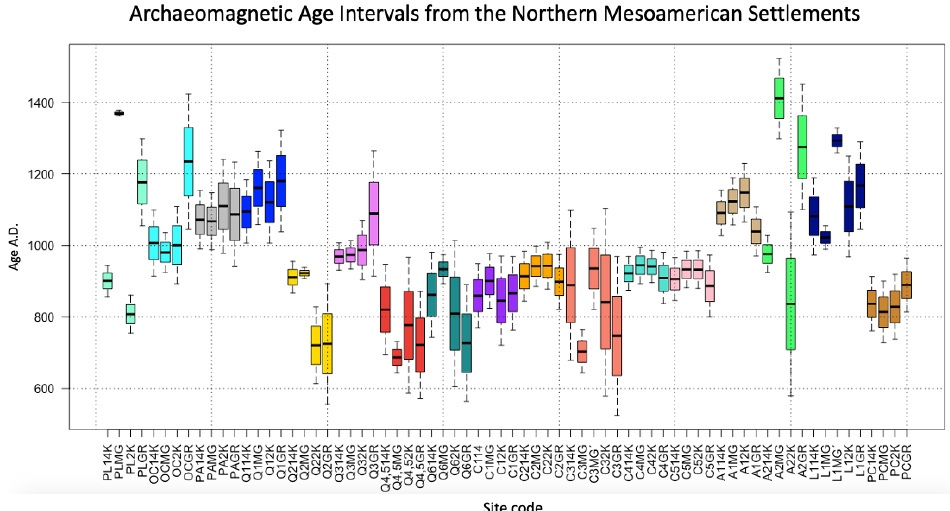
Figure 2. Possible archaeomagnetic age intervals computed using global geomagnetic models and regional reference paleosecular variation curves (see text for more details). Table 1. Available archaeomagnetic data for the archaeological sites belonging to the northern frontier of Mesoamerica indicating their location, possible age intervals and the geomagnetic model used.